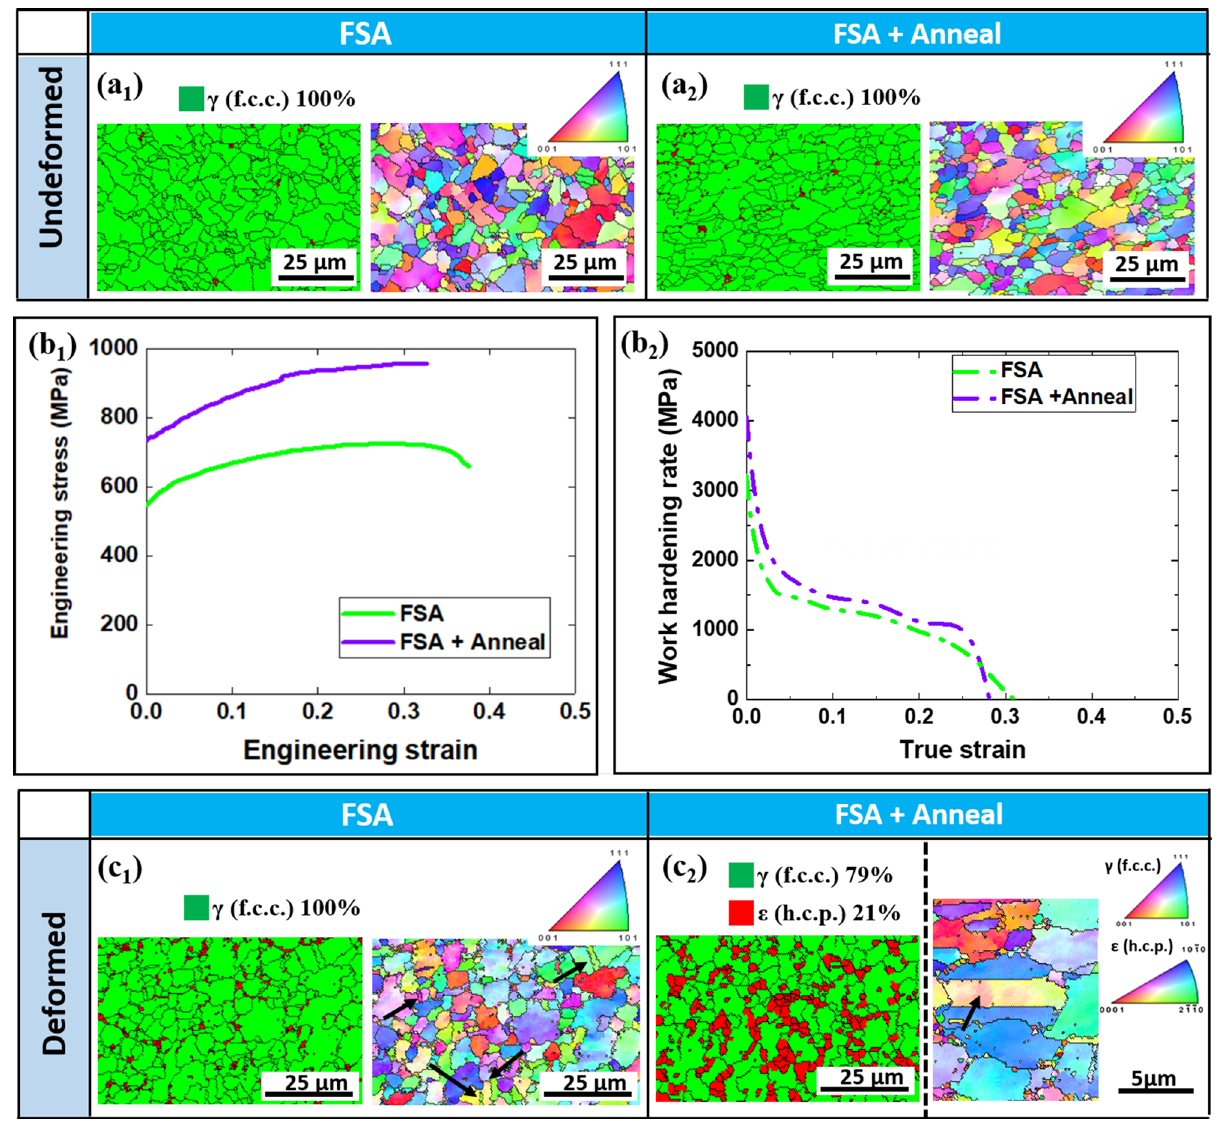
Figure 3. EBSD phase map and IPF map of ( a 1 ) FSA and ( a 2 ) FSA + Anneal specimens in undeformed condition; ( b 1 ) engineering strain–stress and ( b 2 ) work hardening rate curves of FSA and FSA + Anneal specimens under quasi static tensile testing load; EBSD phase map and IPF map of ( c 1 ) FSA and ( c 2 ) FSA + Anneal specimens in deformed condition. Note that deformational twins are labelled by black arrows in ( c 1 and c 2 ). Also note that the red color displayed in phase map of ( a 1 ), ( a 2 ) and ( c 1 ) represent regions with low confidence indexes values rather than ε (HCP)